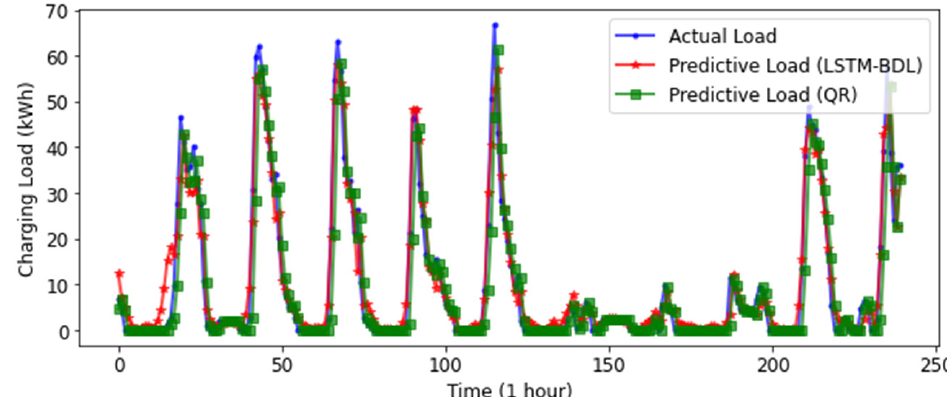
Figure 5. Probabilistic EV charging station load forecasting result.